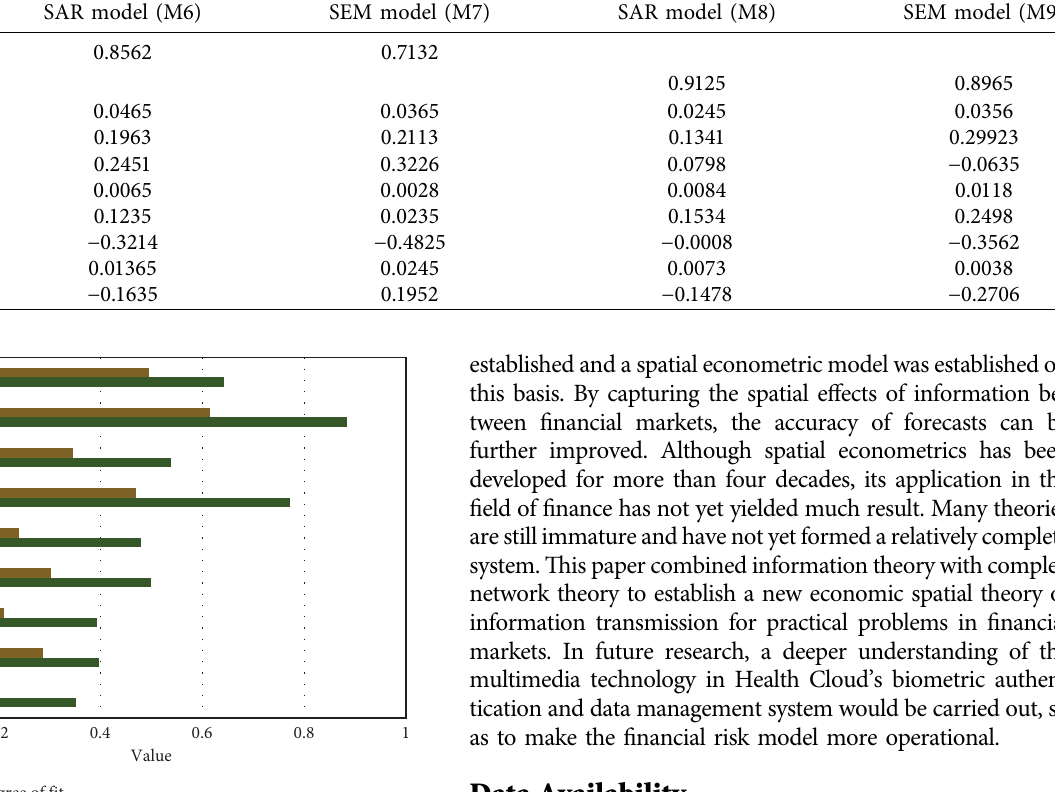
Figure 9: Model ft comparison.